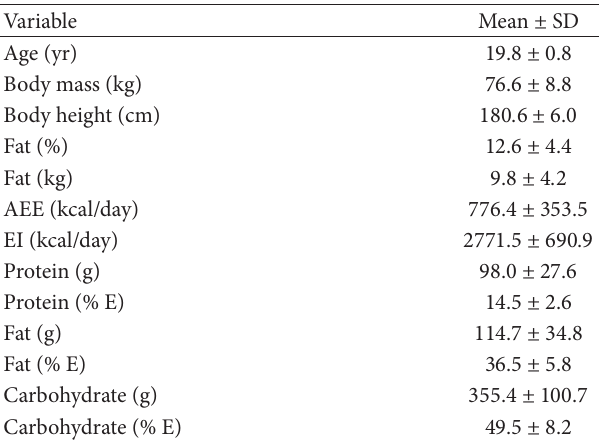
Table 1: Characteristics of the 87